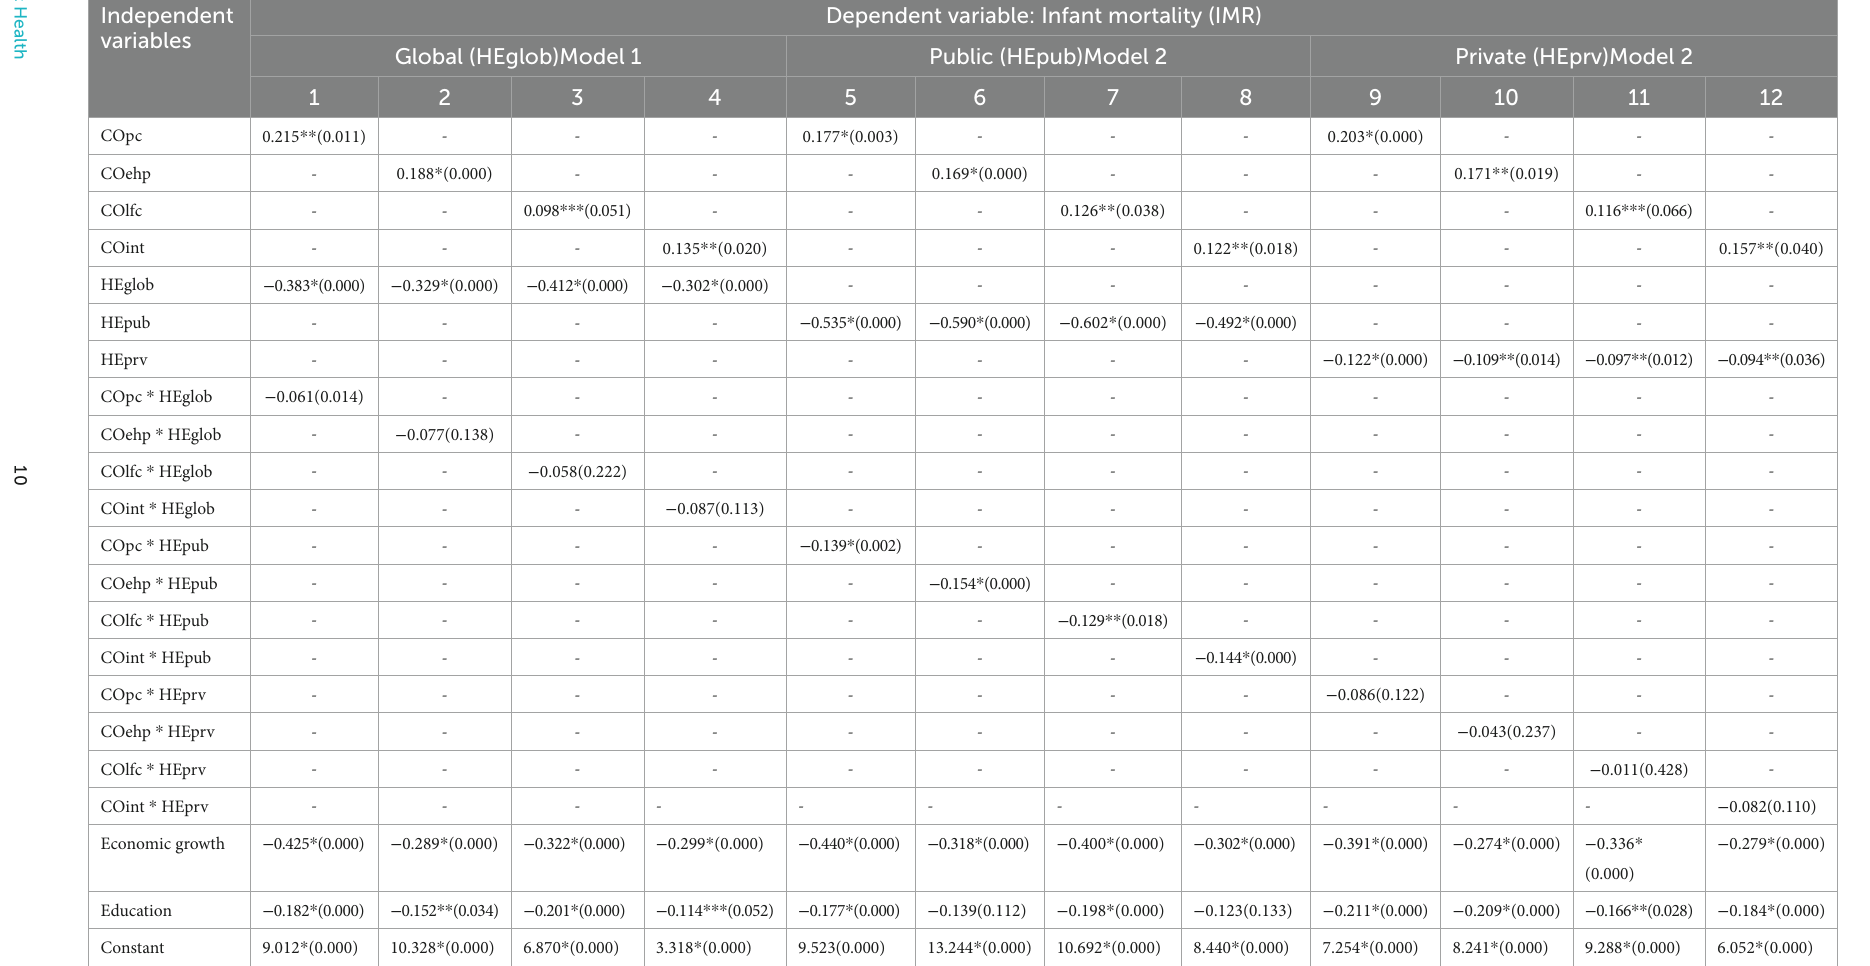
TABLE 4 Results of the impacts of health expenditure and environmental degradation on infant